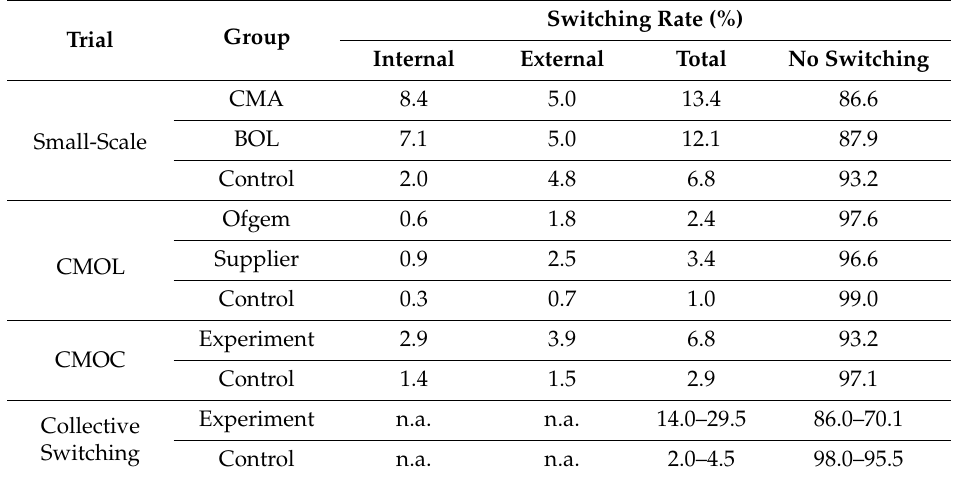
Table 4. Switching rates of the O ffi ce of Gas and Electricity Markets (Ofgem) trials: A summary. Trial